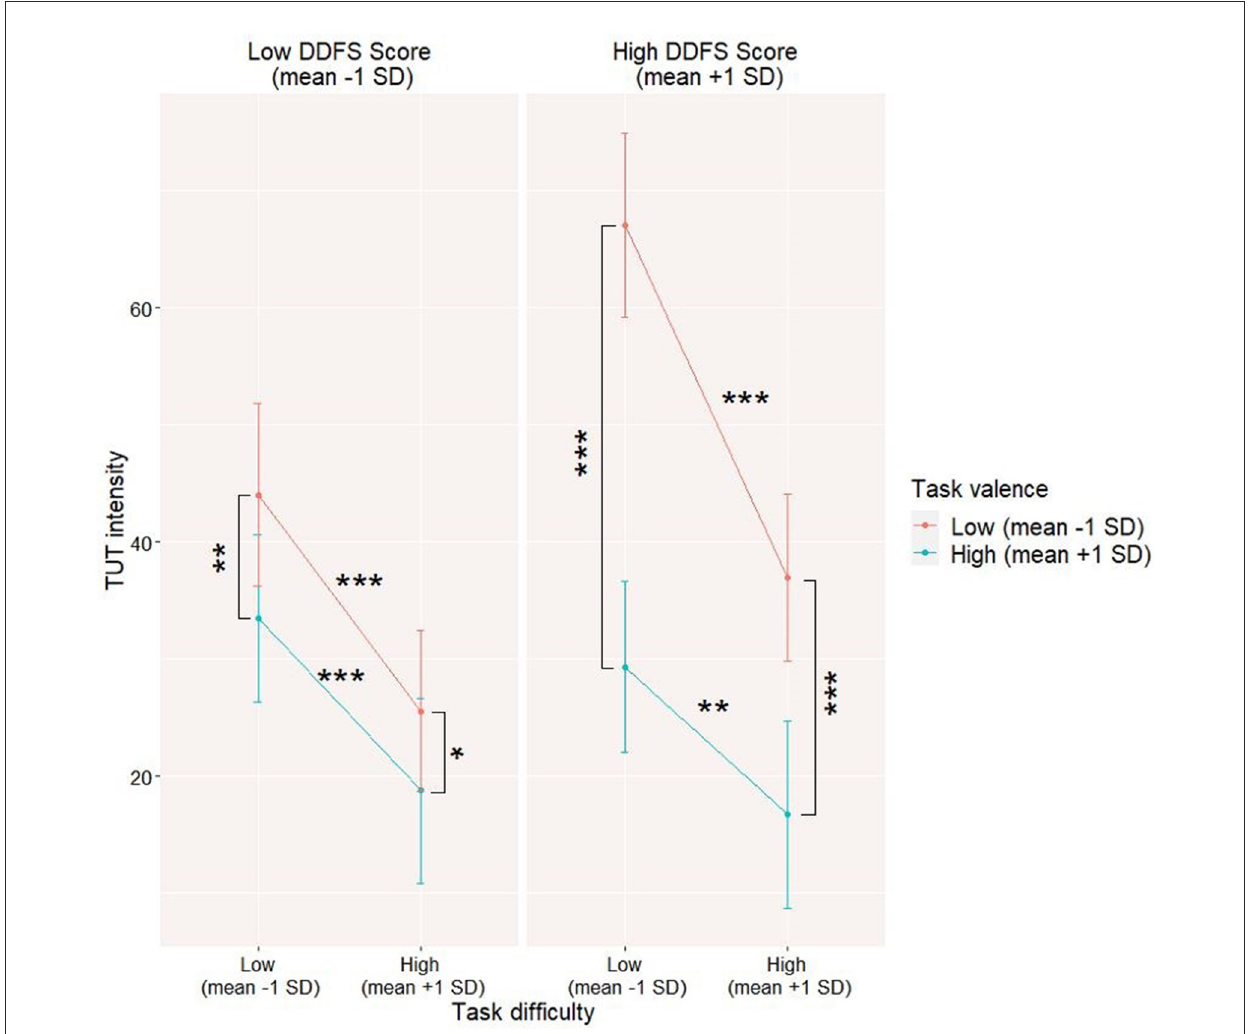
FIGURE4 Daydreaming Frequency Scale (DDFS) moderating level 1 interaction between task valence and task difficulty on task-unrelated thoughts (TUT) level. The data for the moderation model were visualized by computing slopes for high (mean + 1SD) and low (mean-1SD) levels of each predictor